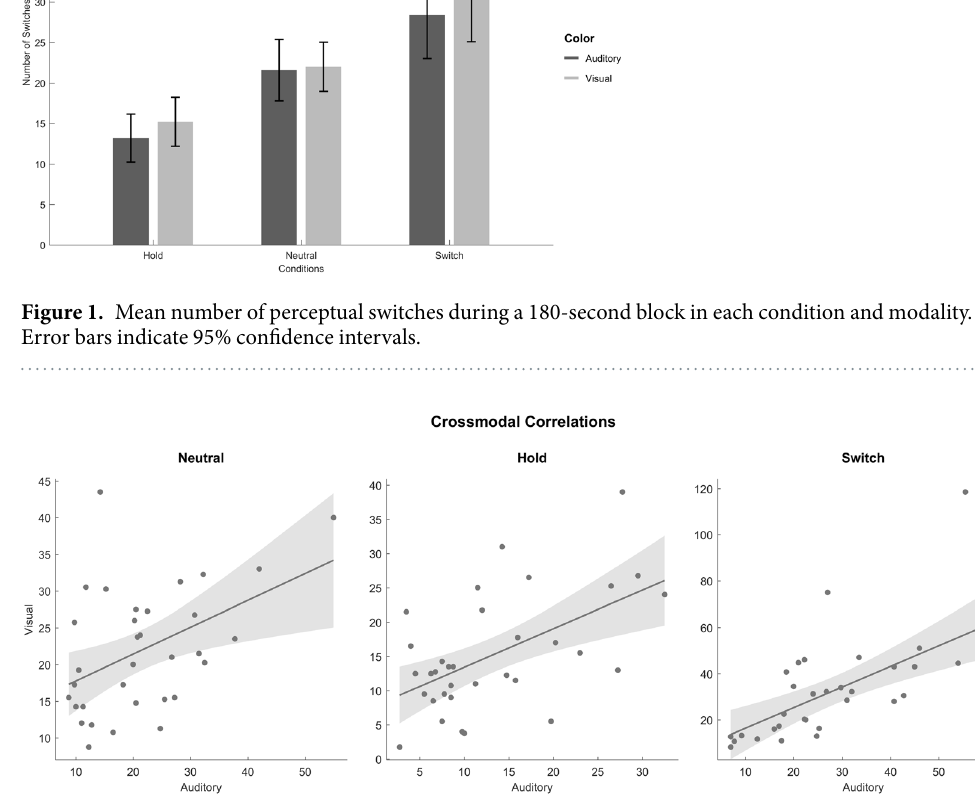
Figure 2. Correlations in the number of perceptual switches across modalities, separately for each condition; shading indicates 95% confidence intervals of the slope of the regression